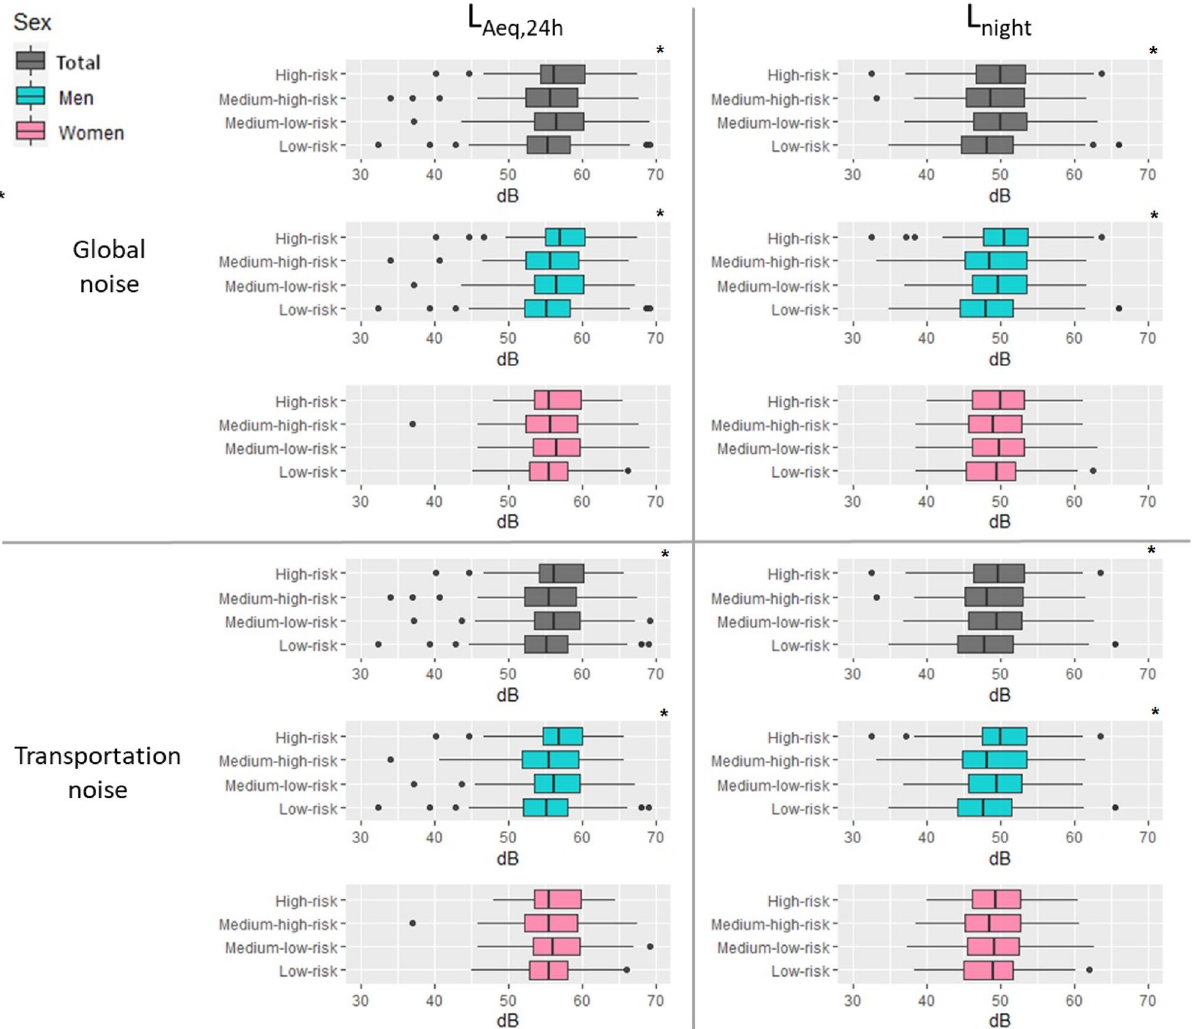
Figure 3. Levels of global and transportation noise exposure, for 24 h and at night, in men and women. *p-value < 0.05, model adjusted on socio-economic level and cardiac frequency (Model